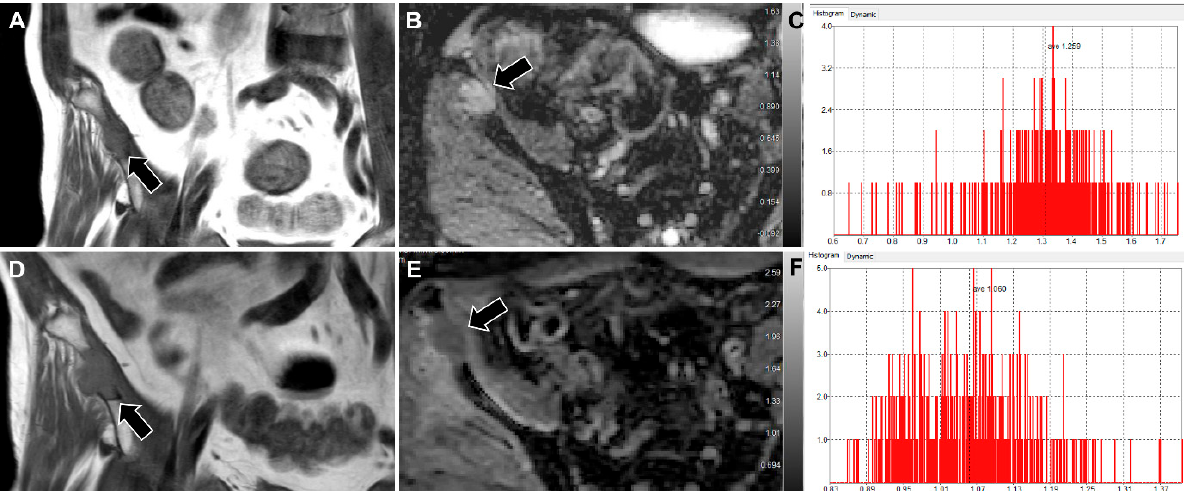
Figure 4. Images of a 63-year-old man with metastasis to the right iliac bone from a hepatocellular carcinoma. ( A , D ) Coronal T1WI, ( B , E ) ADC maps, and ( C , E ) histograms showing the pixel distribution of ADC values in selected VOI from the pre-RT ( A – C ) and post-RT ( D – F ) MRI are shown. Compared with pre-RT MRI, the mean and SD of ADC values of post-RT MRI were decreased from 1.26 to 1.06 (×10 –3 mm 2 /s) and 0.18 to 0.10, respectively, with R ADC mean and R ADC SD calculated to be 0.84 and 0.56, respectively. The sum of greatest diameters increased from 5.9 to 8.7 cm, representing PD. T1WI, T1-weighted image; ADC, apparent diffusion coefficient; VOI, volume of interest; RT, radiation therapy; SD, standard deviation; PD, progressive disease.